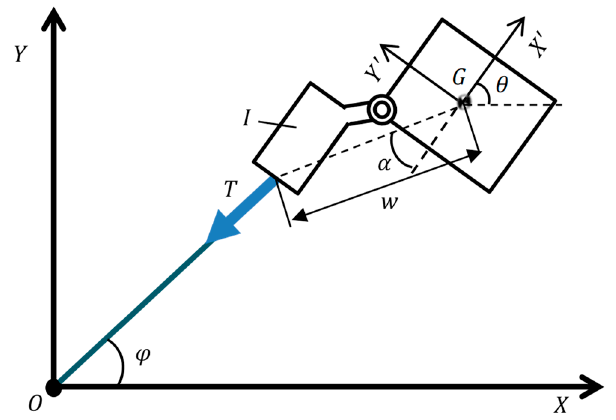
Figure 13. Model of the TSMD when the tether is under strain.